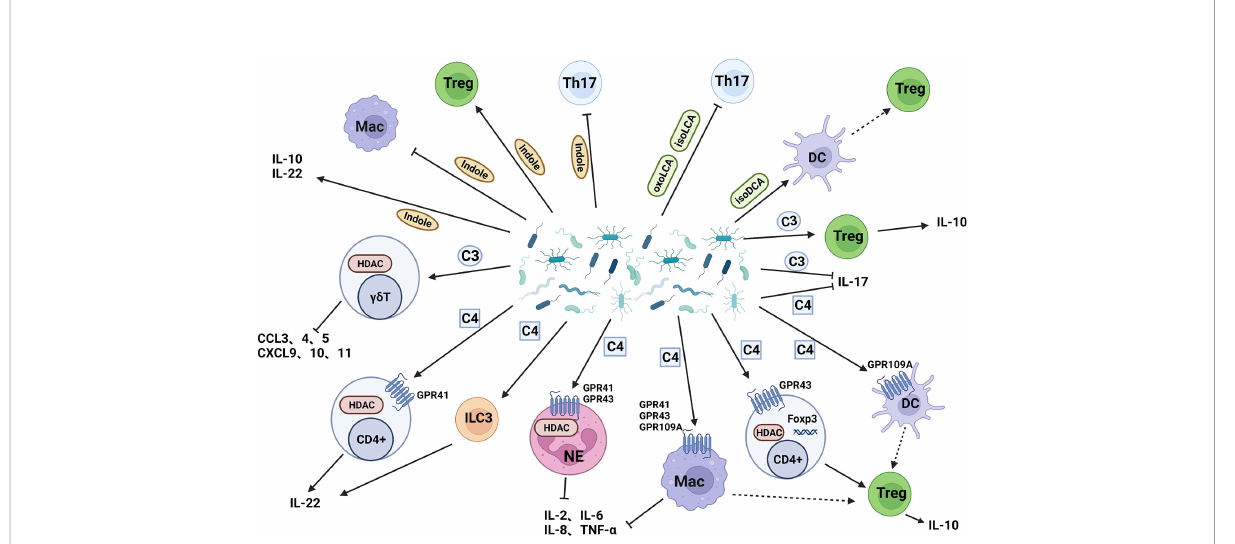
FIGURE 3 Intestinal bacterial metabolites act on IMC. (I) Butyrate acts on dendritic cells, neutrophils, and macrophages through GPR to induce Treg cells differentiation, reduce the release of proin fl ammatory cytokines, and induce Treg cells differentiation by inhibiting HDAC; (II)Propionate reduces the release of pro-in fl ammatory chemokines and promote the secretion of IL-10 by Treg cells; (III) Secondary bile acids inhibit Th17 cells and induce Treg cells production through dendritic cells; (IV) Indole inhibit Th17 cells and macrophages, induce Treg cells production, and improve intestinal cell junction and barrier function. C3: Propionate, C4: